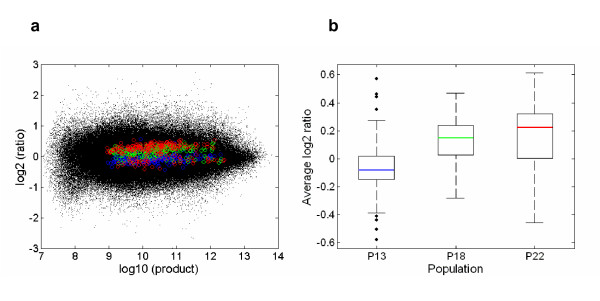
Microarray signature. Gene expression profiles in the three thermal regimes. (a) Expression ratio versus fluorescence intensity of the 316,229 spots (black dots) from the 4,651 clones approved for statistical analyses. The averages for those probes identified as differentially expressed when contrasting the two extreme thermal regimes (i.e.,13°C vs. 22°C) are in blue (P13), green (P18) and red (P22). (b) Box-plots of the average expression ratios for the differentially expressed genes.